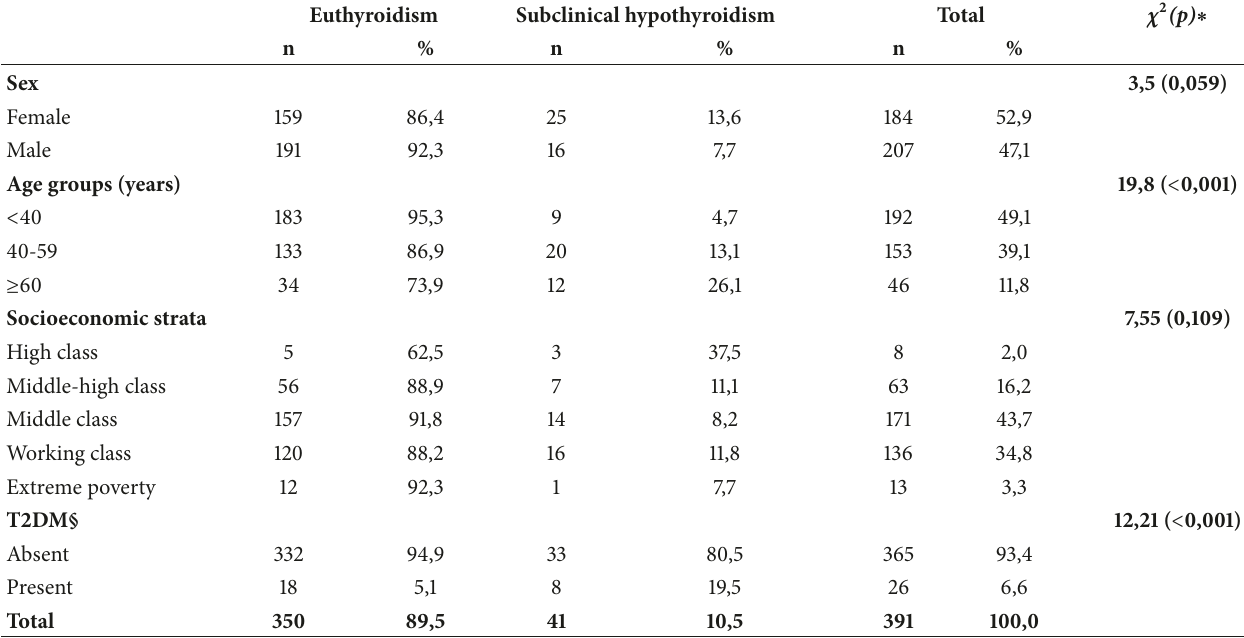
Table 1: General characteristics according to the presence of subclinical hypothyroidism in adults from Maracaibo City, Venezuela.